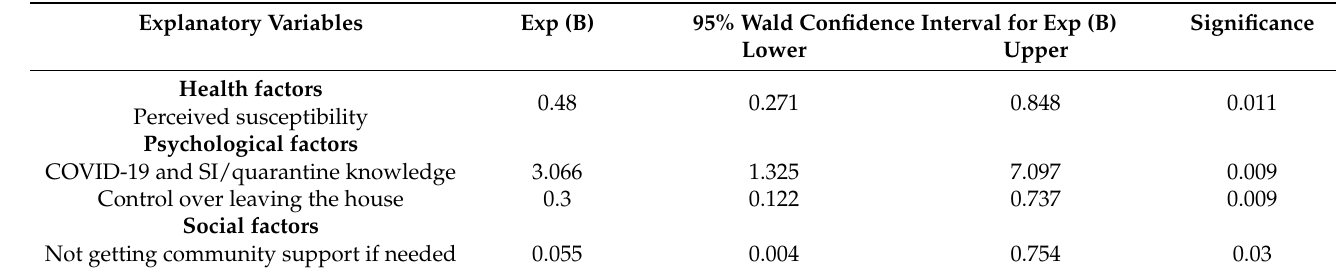
Table 5. Results of logistic regression for significant explanatory variables, with binary outcome variable of non-adherence or adherence to quarantine rules (co-habitant